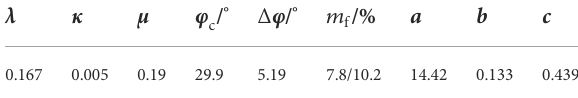
TABLE 3 Model parameters for this proposed model prediction. Data from the MSW in this paper.